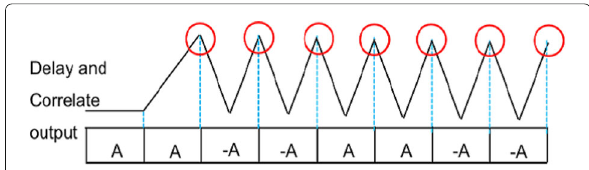
Fig. 4 OFDM symbol boundary